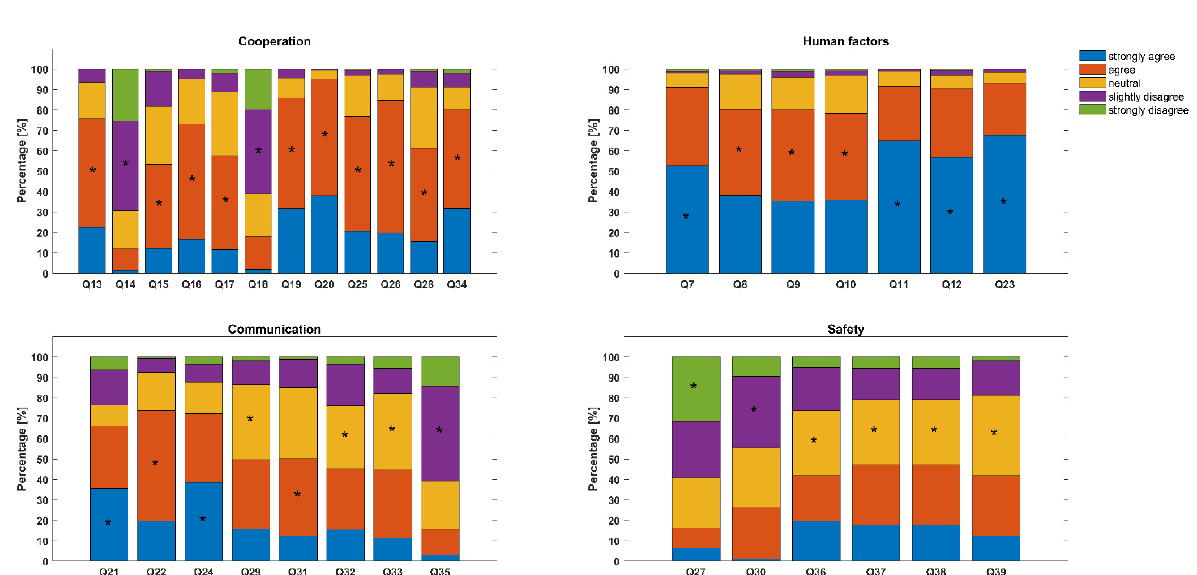
Figure 2. Results of Q13 to Q39 related to the specified factors. Asterisks within each stacked bar plot indicate the mode for ratings.